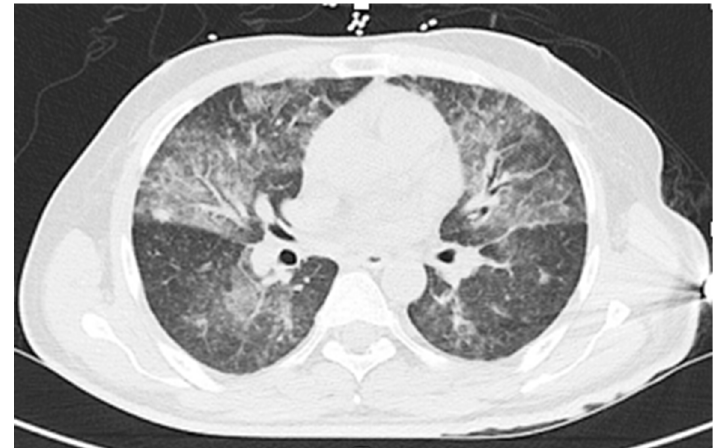
Figure 5. Case 2: CT of the chest showing extensive ground glass and patchy parenchymal